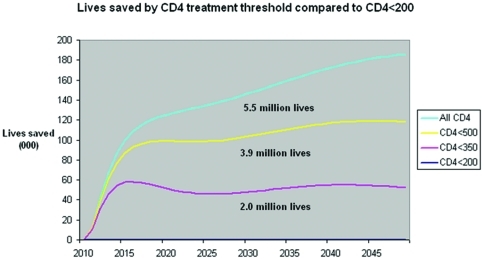
Lives saved by CD4 treatment threshold compared to current CD4<200 baseline.Graph shows lives saved by CD4 treatment threshold compared to current CD4<200 baseline with the <350 scenario portrayed in “pink”, <500 in “yellow” and all CD4 in “blue”. Lives saved increase with earlier access to ART.